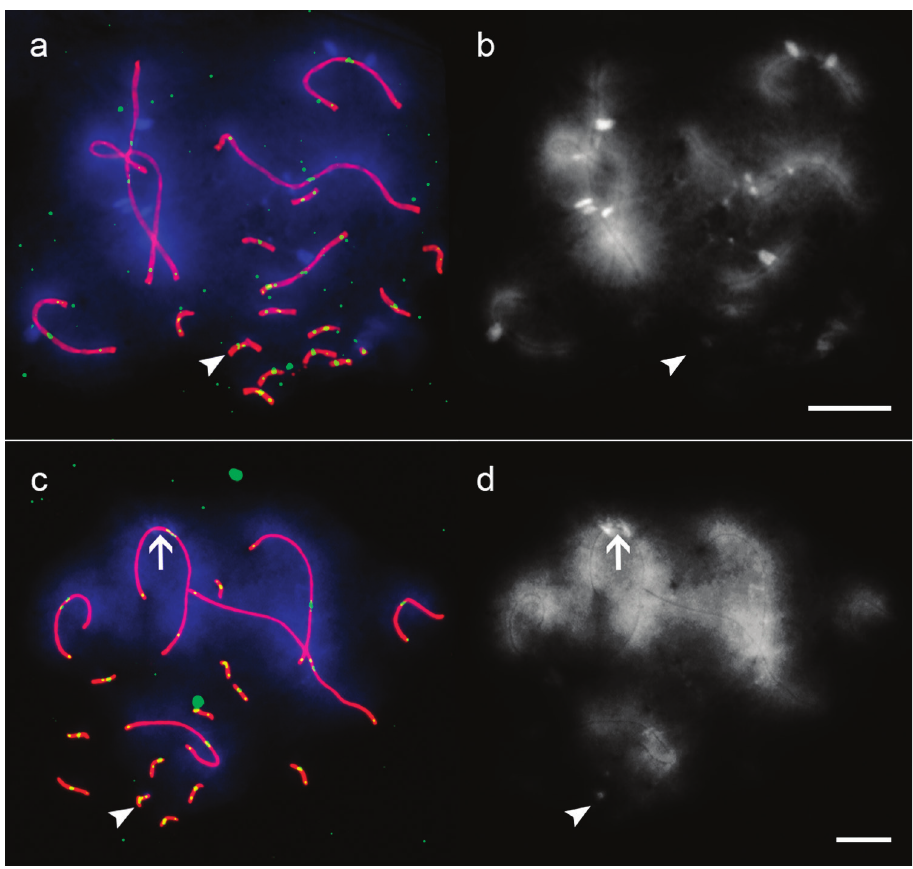
Figure 1. The SC spreads of A. carolinensis ( a, b ) and D. coelestinus ( c, d ). a, c immunofluorescence and DAPI. Red: SYCP3, green: centromere and MLH1, blue: DAPI b, d DAPI channel separately. Arrowheads show the XY bivalent (Lisachov et al. in press). Arrow shows the DAPI+ band on the SC2 of D. coelestinus . Scales bars: 5